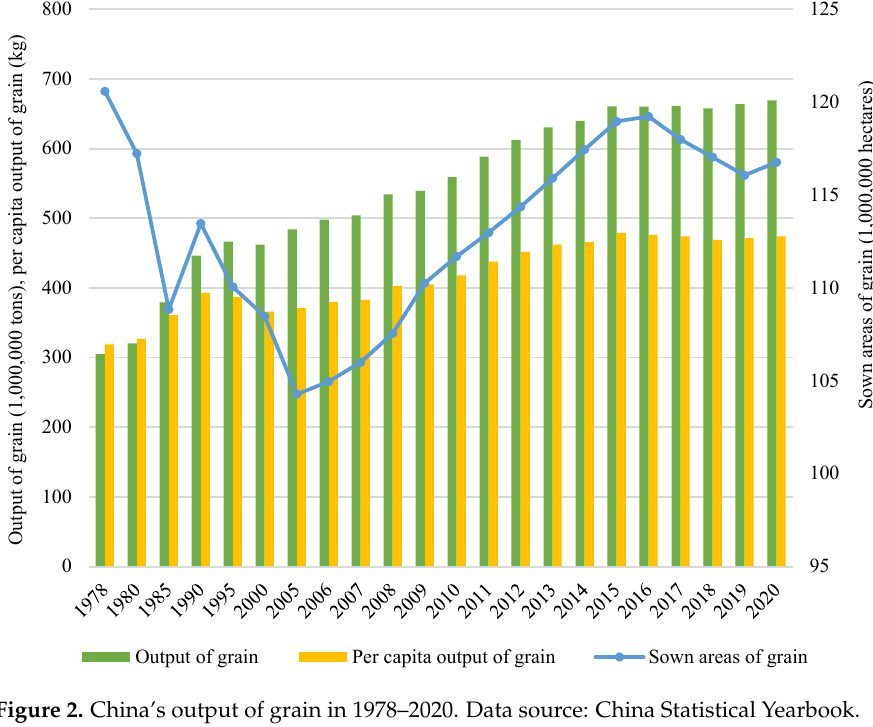
Figure 2. China’s output of grain in 1978–2020. Data source: China Statistical Yearbook.